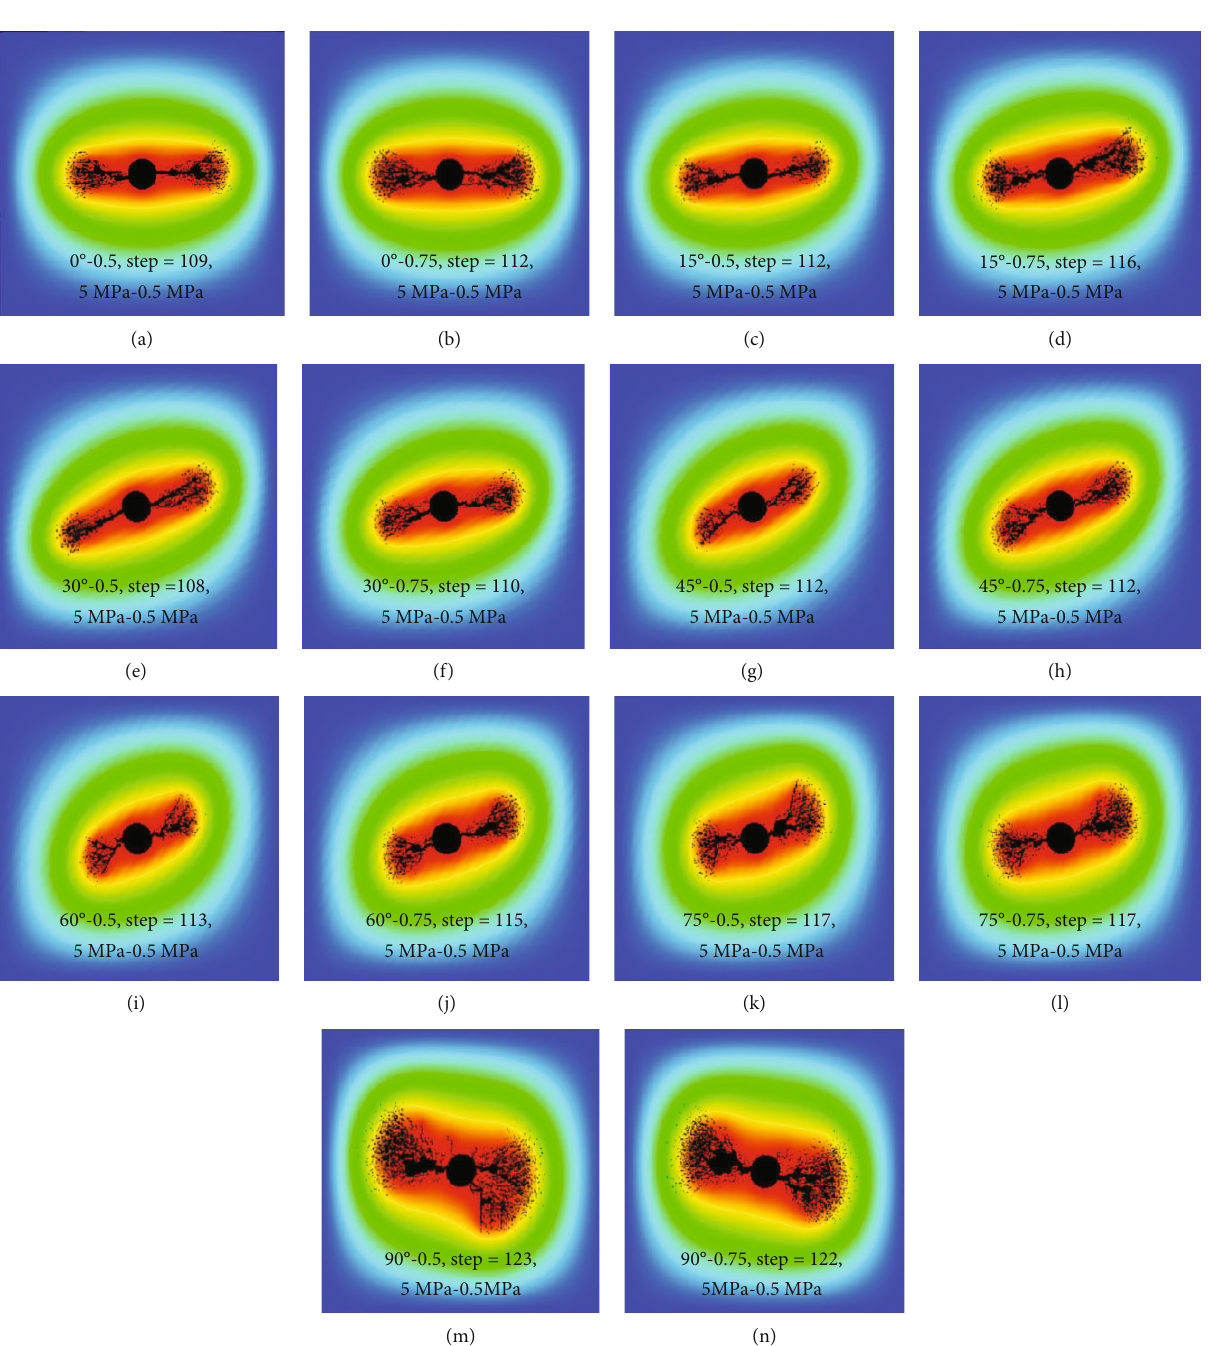
Figure 17: HF morphologies under di ff erent bedding angles and reduction